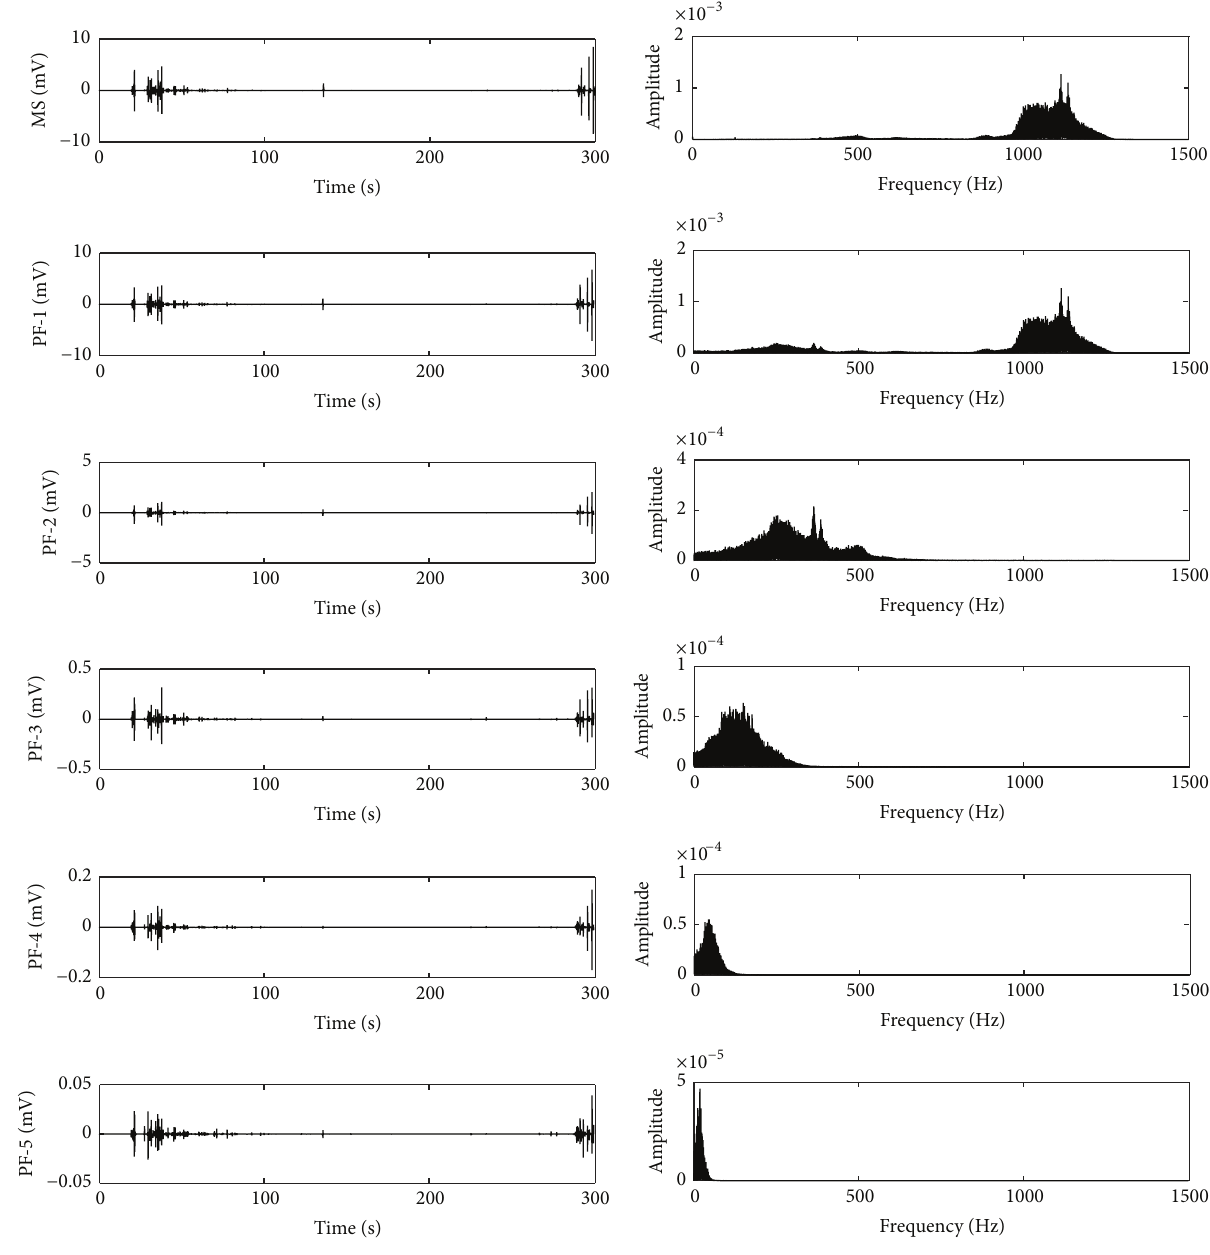
Figure 5: A typical LMD result of